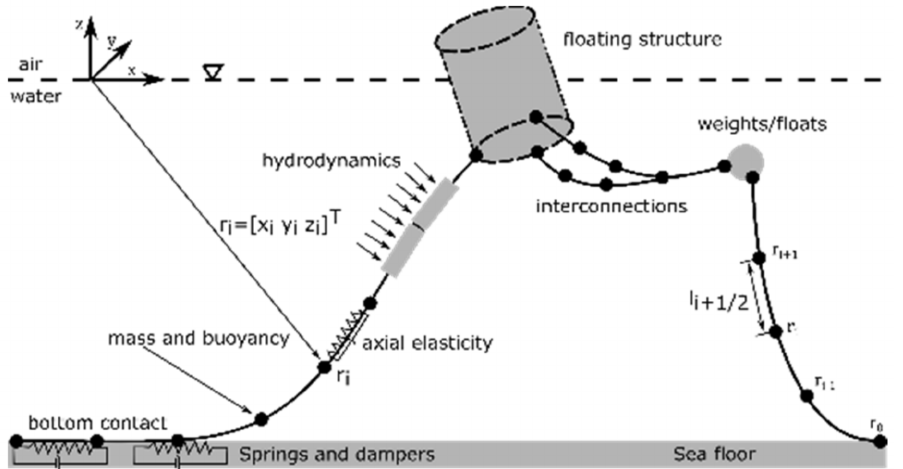
Figure 3. The discretized mooring model adopted from